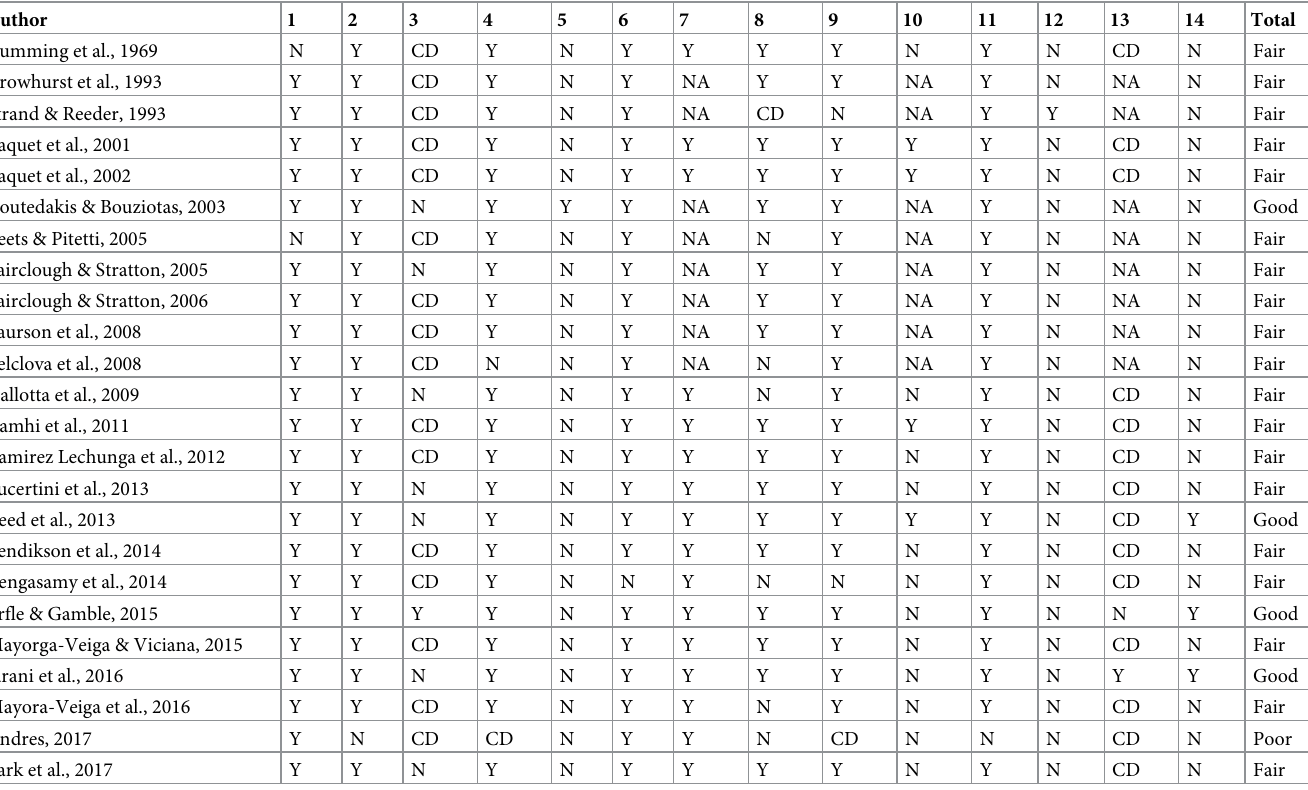
Table 1. Risk of bias of included studies.